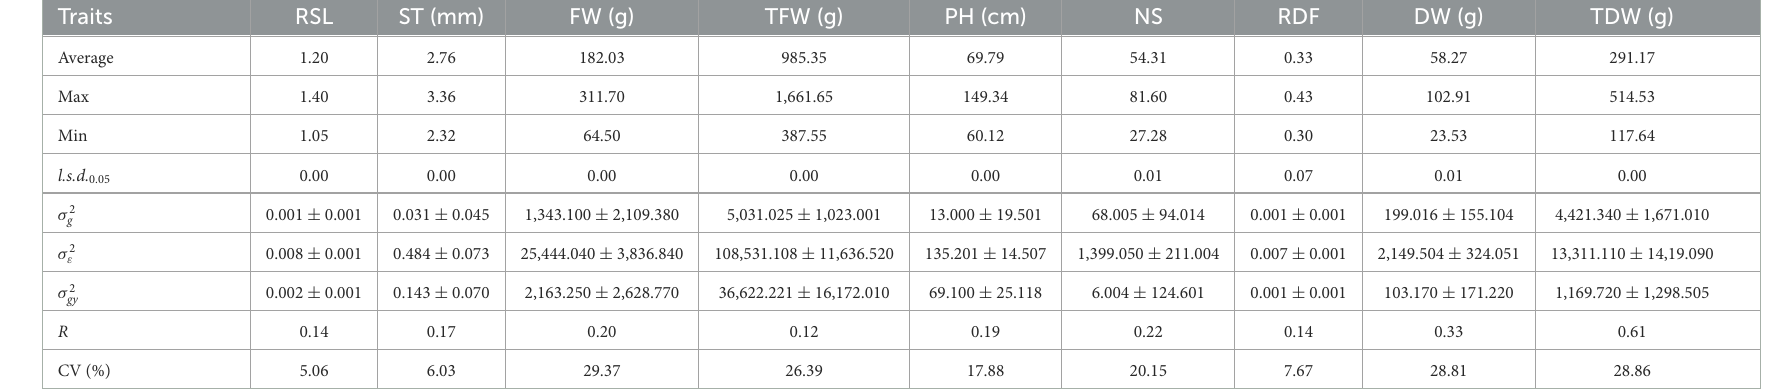
TABLE 4 Average, maximum, minimum, least significant differences ( l.s.d. 0.05 ), estimated genotypic ( σ 2 g ) and experimental error ( σ 2 ε ) variance components and associated standard errors ( ± SE), and mean repeatability ( R ) estimated from the 44 varieties of alfalfa evaluated in 2020.